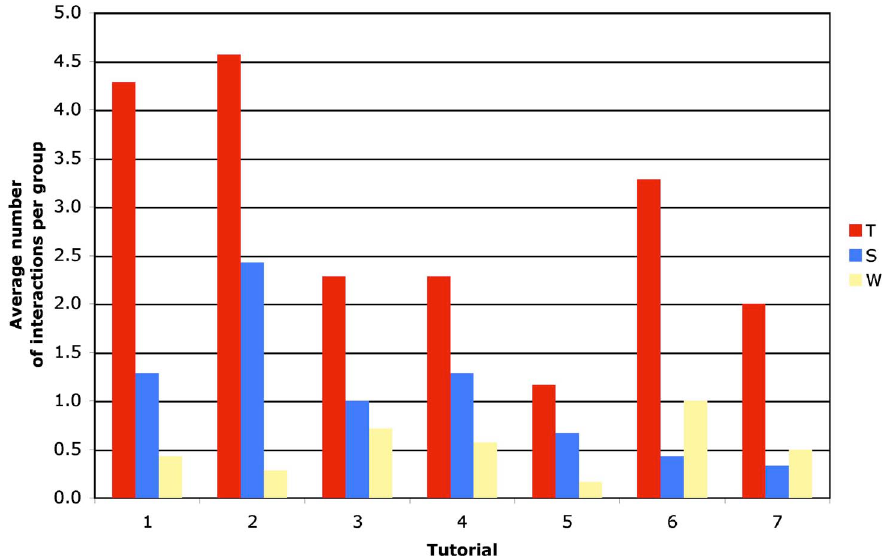
FIG. 4. (cid:1) Color (cid:2) Average num- ber of interactions of each type that occurred per group for each